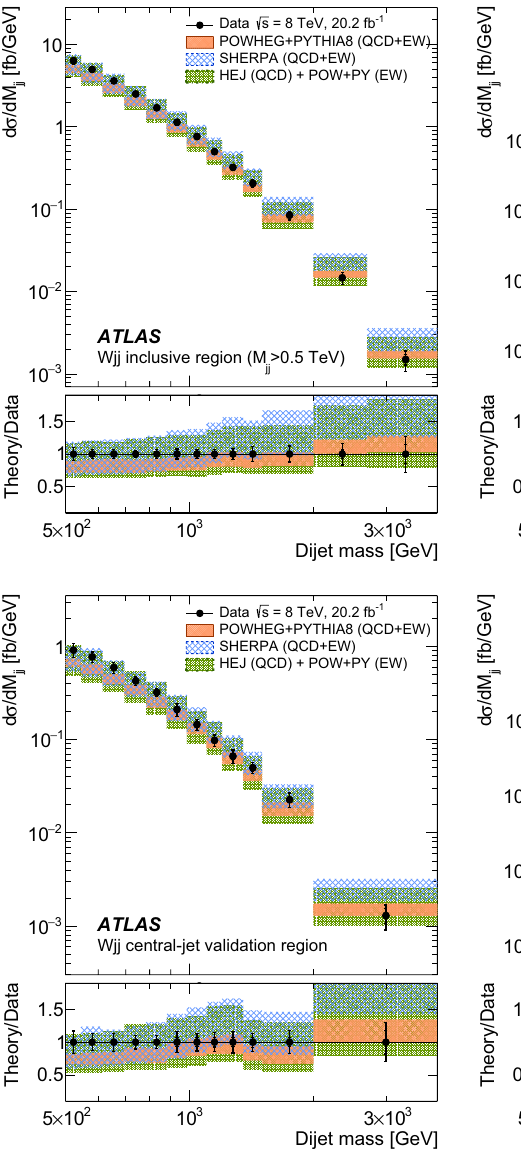
statistical ( inner bar ) and total ( outer bar ) measurement uncertainties are shown, as well as ratios of the theoretical predictions to the data (the bottom panel in each